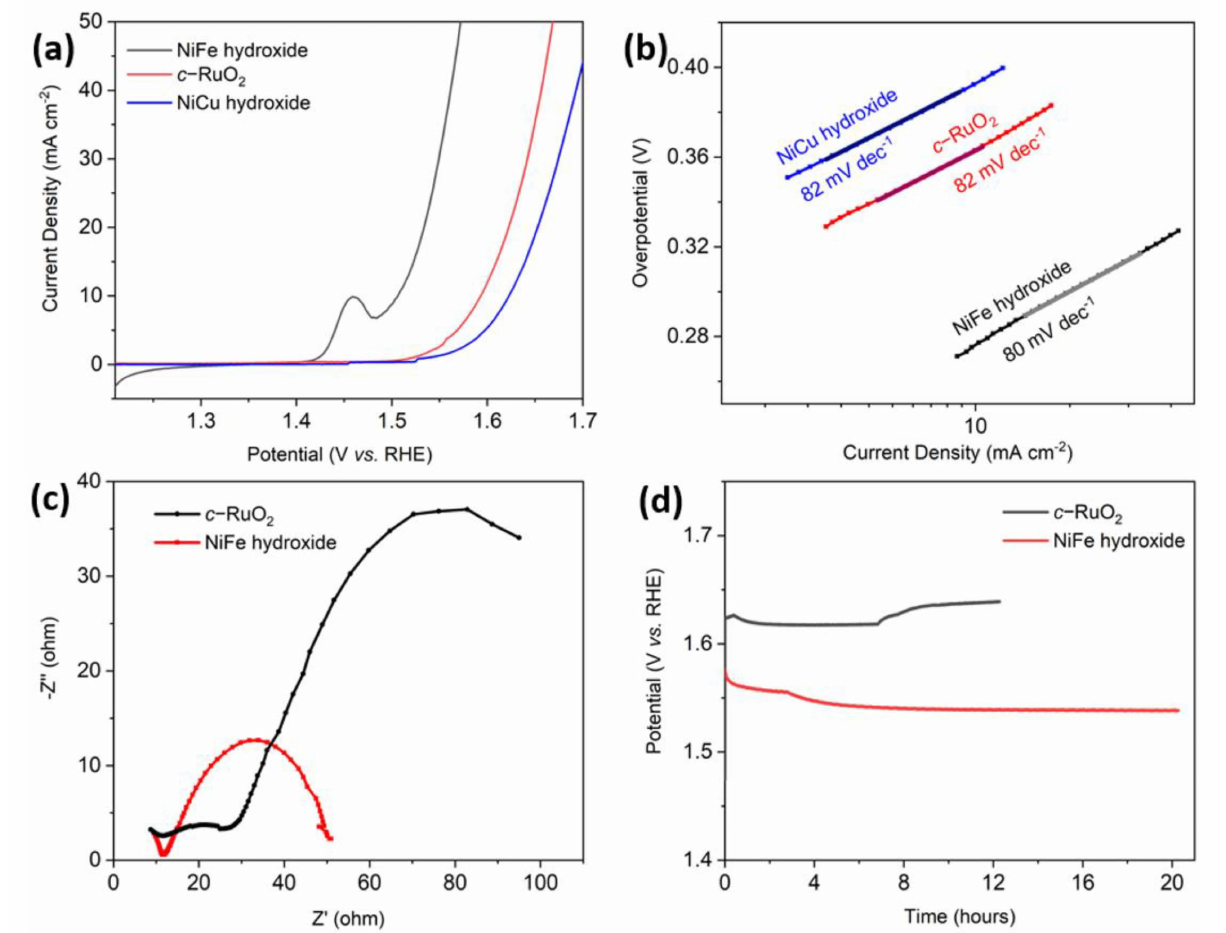
Figure 3. ( a ) Linear sweep voltammetry (LSV) curves of as-prepared nanoparticles of NiFe-hydroxide, NiCu-hydroxide and commercial c-RuO 2 catalysts in 1 M KOH electrolyte. ( b ) The corresponding Tafel plots derived from LSV curves. ( c ) Nyquist plots recorded for NiFe-hydroxide and c-RuO 2 at an applied potential of 1.50 V (vs. RHE). ( d ) Chronopotentiometric curve for NiFe-hydroxide and c-RuO 2 at a constant current density of 20 mA cm − 2 for more than 20 h in 1 M